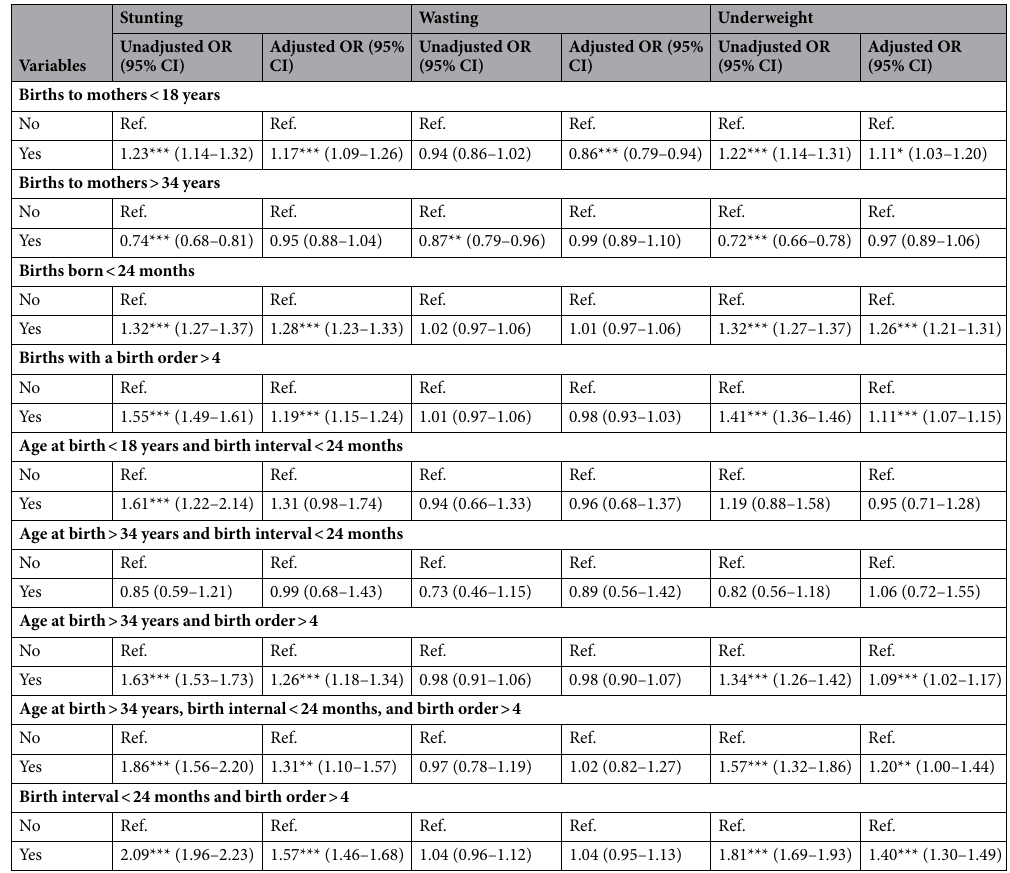
Table 6. Unadjusted and adjusted odds ratios using binary logistic regression models investigating of the relationship between mother high-risk births behaviour and children’s nutrition outcomes, India, (NFHS-4). Adjusted models were controlled for children age, child sex, mother education, mother body mass index, contraceptive use, household’s members, wealth, religion, caste, source of drinking water, place of residence, region. OR: Odds Ratio, CI: Confidence Interval. Significant level: *** p < 0.001, ** p < 0.01, * p <